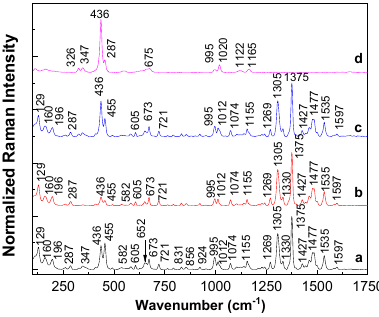
Figure 5. Raman spectra of the ST-reacted AZA samples with ST concentrations in the reaction mix-